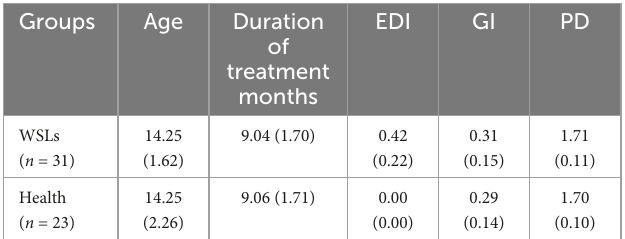
TABLE 1 Means (standard deviation) of demographic data in this study. Groups